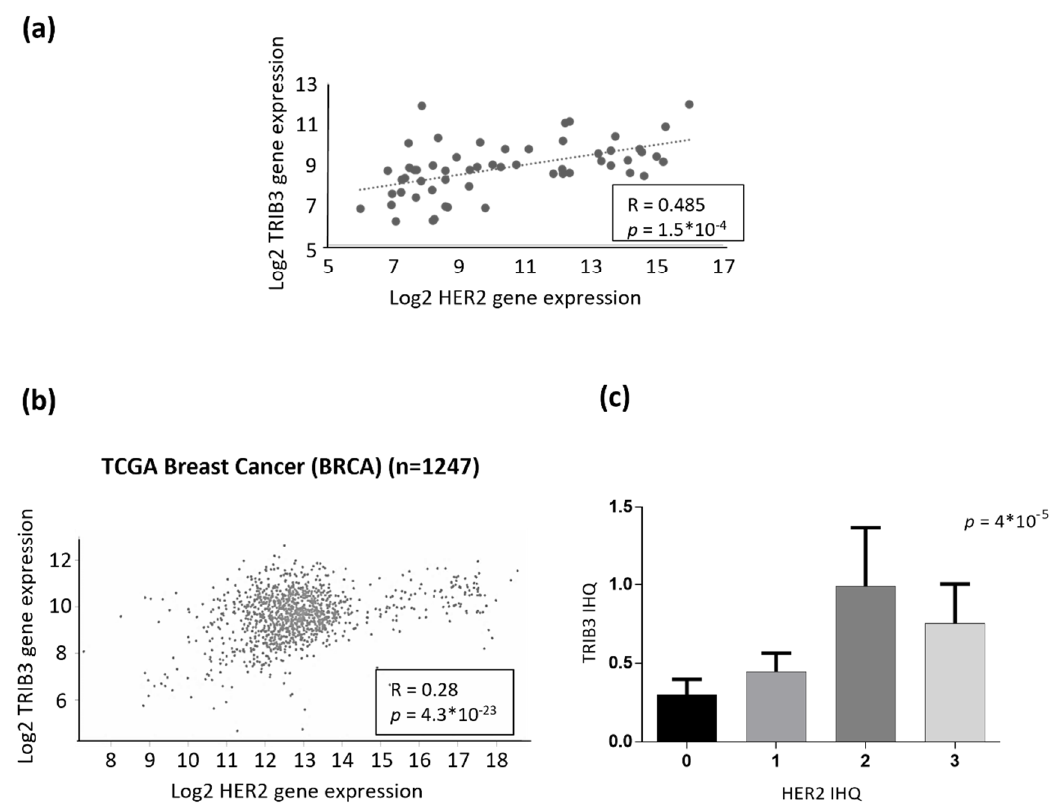
Figure 3. TRIB3 and HER2 expression exhibit a positive correlation in breast cancer. ( a ) Bioinformatic analysis of the correlation between TRIB3 and HER2 mRNA levels in a panel of breast cancer cell lines (RNA seq data were obtained from the GSE48216 dataset). ( n = 56; p and R were calculated using Spearman’s correlation coefficient). ( b ) Bioinformatic analysis of the correlation between TRIB3 and HER2 mRNA levels in breast cancer patients (RNA seq data were obtained from the TGCA Breast cancer dataset using the UCSC Xena platform) ( n = 1247; p and R were calculated using the Spearman correlation coefficient). ( c ) Correlation between TRIB3 protein levels (as determined by TRIB3 immunostaining and the subsequent assignment of the corresponding H value) with respect to HER2 levels (pathologically classified as 0-1-2-3 according to the level of expression of this receptor) in a tissue microarray that was generated with samples that were derived from luminal breast cancer patients ( n = 159; p was calculated using the Spearman’s correlation coefficient).